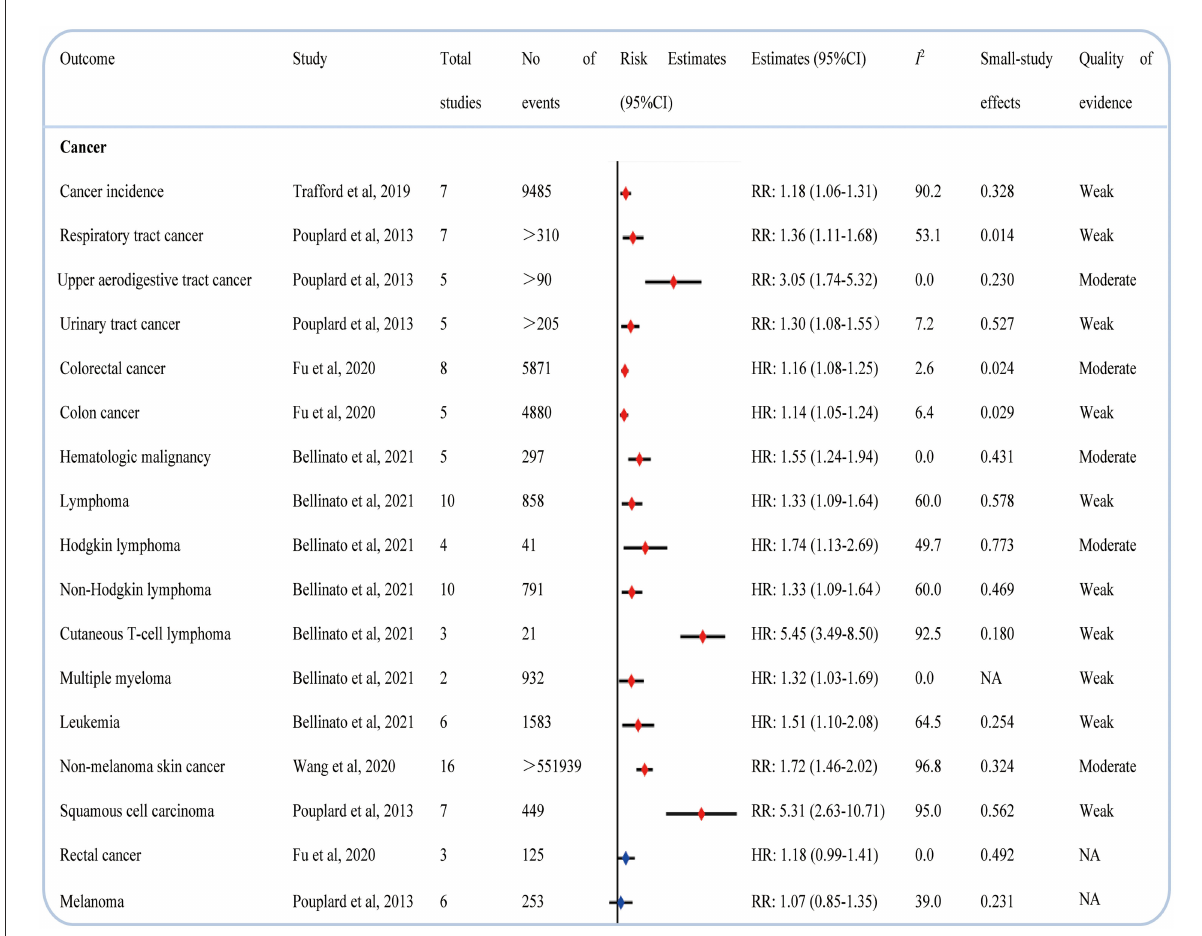
FIGURE4 Associations between psoriasis and cancers.